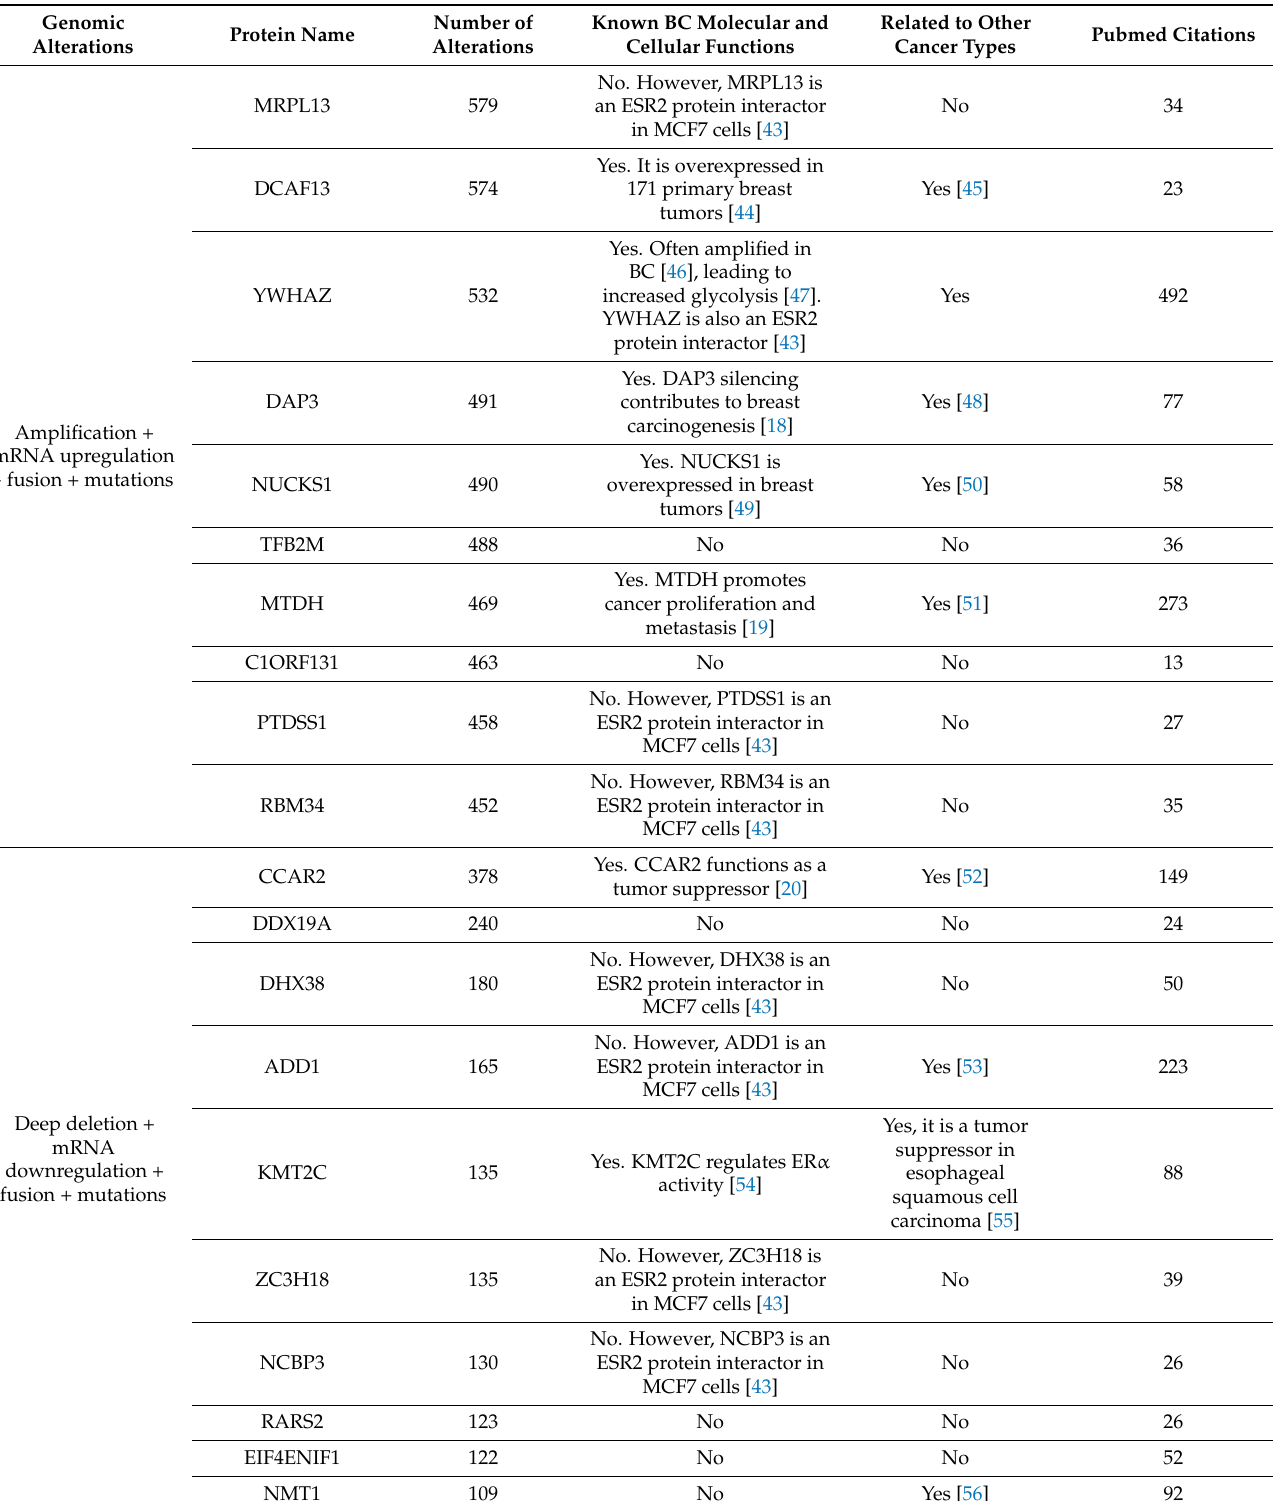
Table 1. Top ten most altered RNA-binding proteins in invasive breast carcinoma (TCGA, PanCancer Atlas) and breast cancer